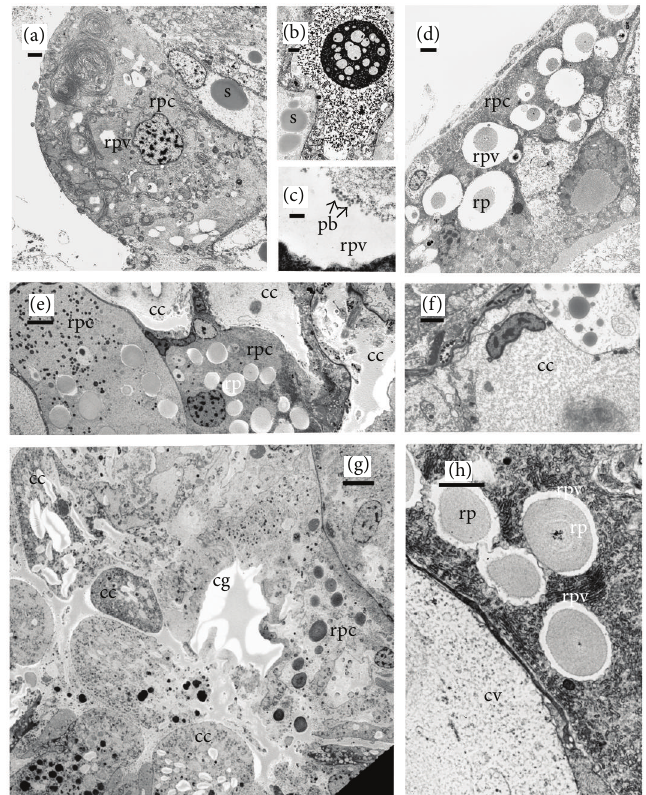
Figure 1: Digestive glands of Aplysia juliana ((a), (b)), Aplysia parvula (d), and Dolabrifera dolabrifera ((c), (e)–(h)). ((a) and (b)) Rhodoplast cell with mainly empty digestive vacuoles and adjacent medium osmophilic granules and large electron-dense granule (compare with [16] Figure 7(a, c)). (c) Rhodoplast digestive vacuole with phycobilisome sized particles (compare with [16] Figure 4(d)). (d) Rhodoplast cell with full digestive vacuoles. (e) Rhodoplast cells with adjacent calcium carbonate granules and (f) a portion of a calcium carbonate cell showing the location of the nucleus. (g) Mature and immature calcium cells with adjacent rhodoplast cells and (h) the whorled appearance of rhodoplasts in rhodoplast cell digestive vacuoles (compare with [16] Figure 4(b, d)) adjacent to a calcium carbonate deposit. cc: calcium cell; cg: calcium carbonate granule; cv: calcium vacuole; pb: phycobilisome; rp: rhodoplast; rpc: rhodoplast cell; rpv: rhodoplast vacuole; s: starch. Scale